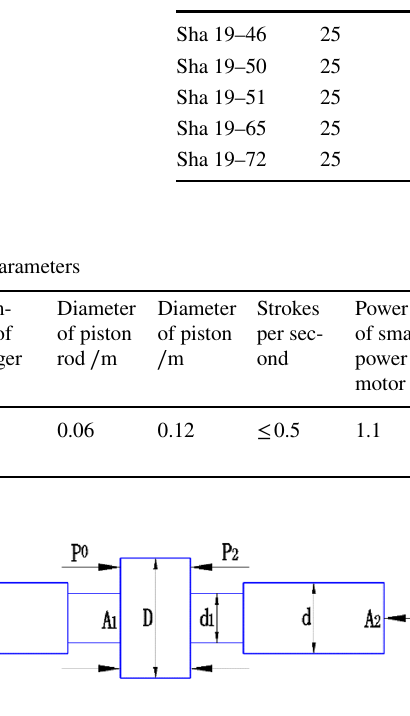
Fig. 7 Mechanical model of the double-acting plunger